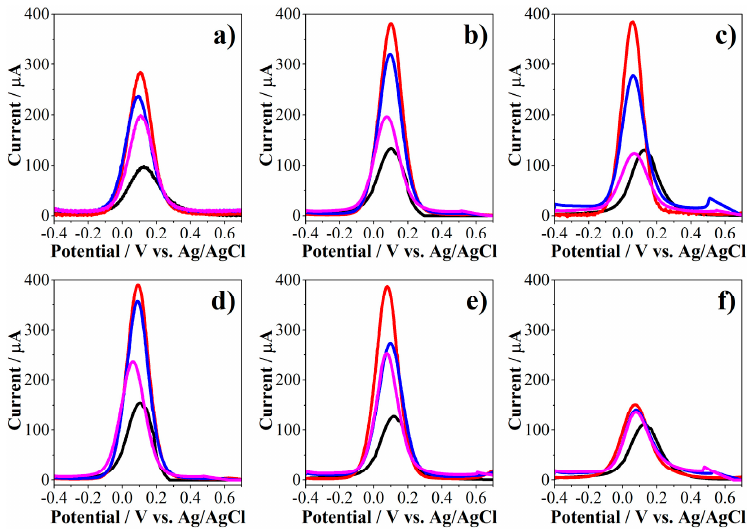
Figure 6. SWV results of the effect of varying the electrodeposition time for ( a ) 20 s, ( b ) 100 s and ( c ) 250 s at a constant potential of − 0.05 V and varying the applied potential at ( d ) +0.05 V, ( e ) − 0.15 V and ( f ) − 0.25 V at constant time of 100 s in the electrodeposition of AuNPs towards the detection of E. coli (500 CFU/mL). The curves correspond to SPE (black lines), SPE/AuNPs (red lines), SPE/AuNPs/PEP (blue lines) and SPE/AuNPs/PEP/EC (rose lines) in all cases. 10 mM of [Fe(CN) 6 ] − 3/ − 4 in 0.1 M of KCl aqueous solution.